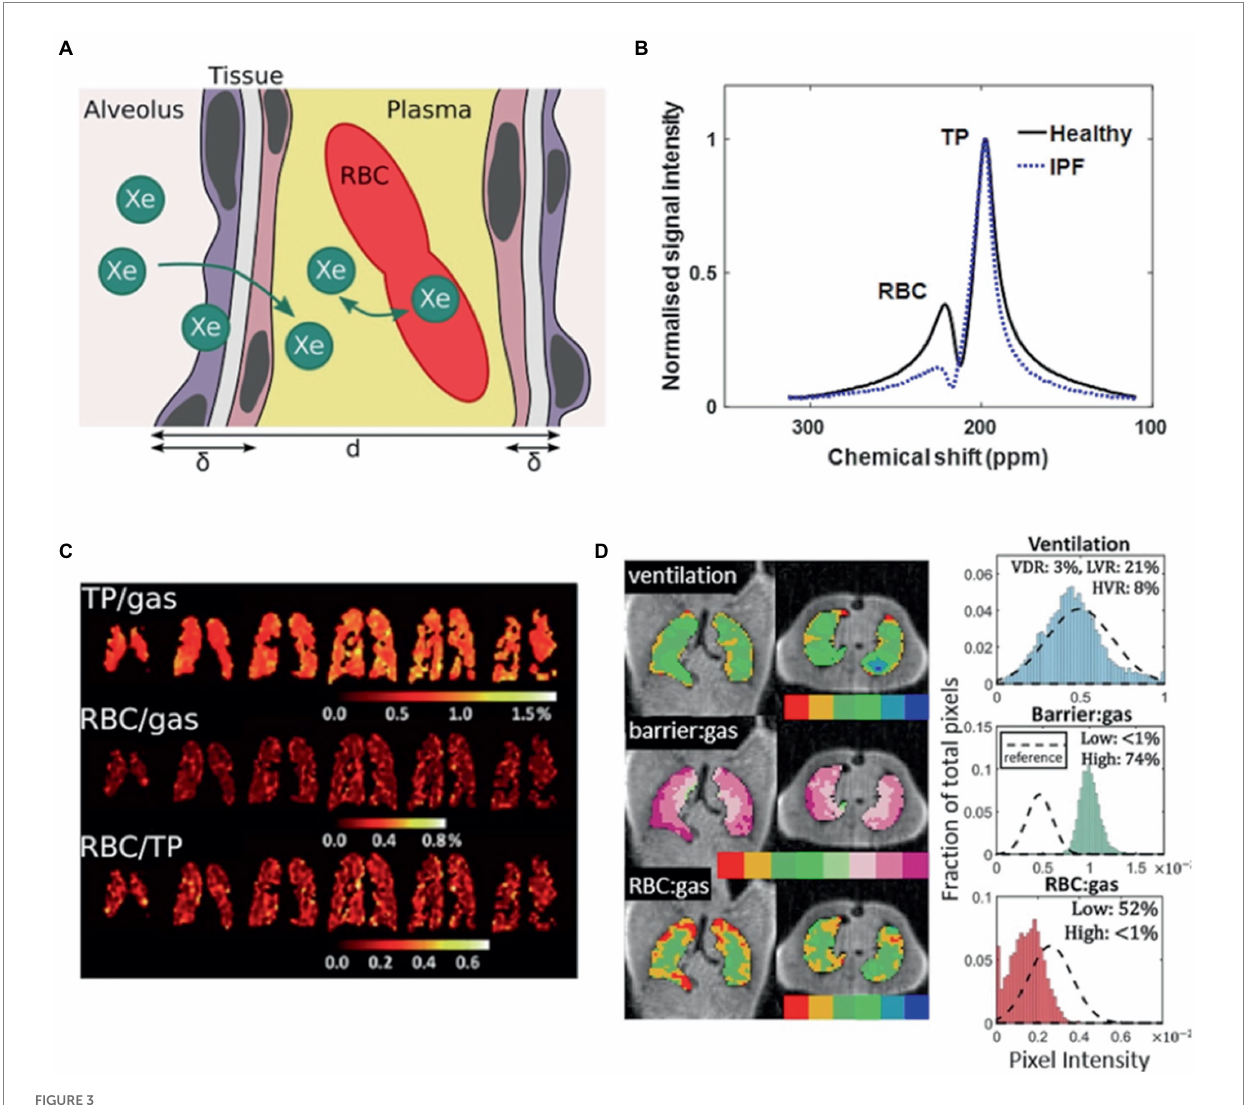
FIGURE 3 Probing gas exchange. (A) Cartoon of diffusive exchange of xenon gas from alveolus to capillary, via the parenchymal tissue barrier. The tissue wall thickness (air-blood barrier thickness) is represented by δ , and the total septal wall thickness separating neighboring alveoli is represented by d . (B) 129 Xe MR spectra obtained from a healthy subject (black line) and a patient with idiopathic pulmonary fibrosis (IPF) (blue line). (C) Iterative Decomposition of water/fat using Echo Asymmetry and Least-squares estimation (IDEAL) chemical shift imaging of dissolved 129 Xe in the lungs of a patient with moderate chronic obstructive pulmonary disease, illustrated in the form of ratio maps. (D) Representative binning maps and histograms derived from Dixon- based dissolved-phase 129 Xe MRI acquired from a patient with IPF, highlighting the characteristic high TP (barrier) signal and low RBC signal compared with healthy normal subjects (dashed histogram). (The notation barrier: gas is equivalent to TP/Gas). Adapted with permission from